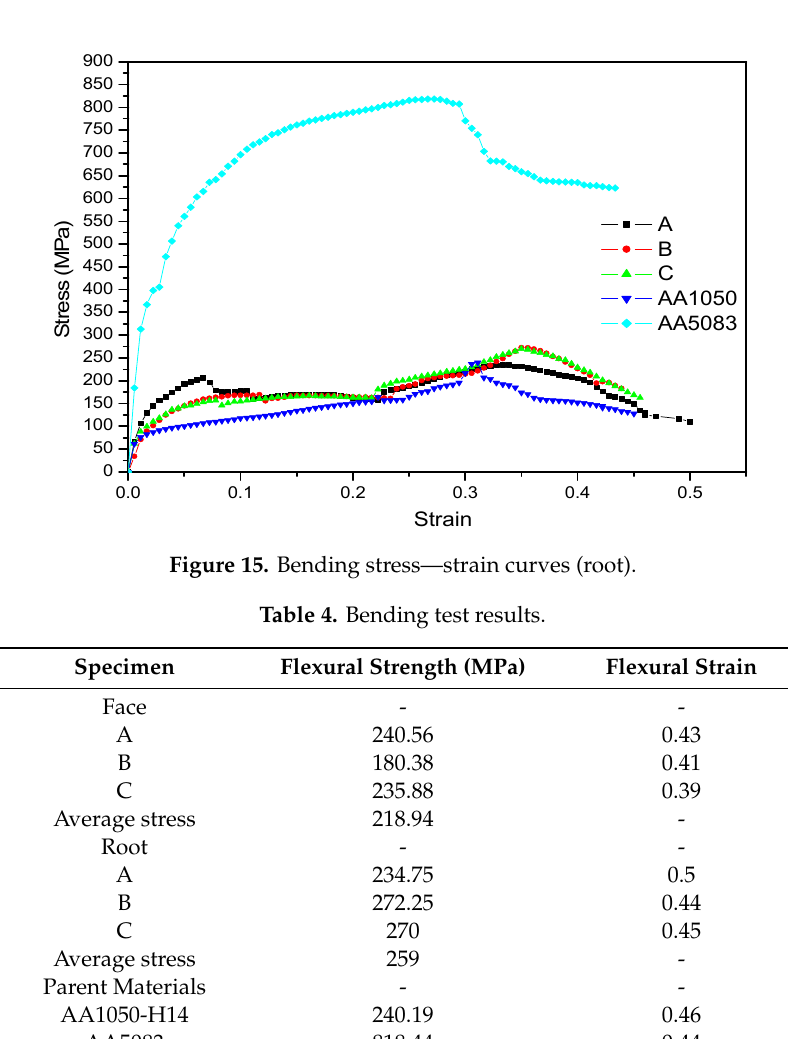
Figure 14. Bending stress—strain curves (face).